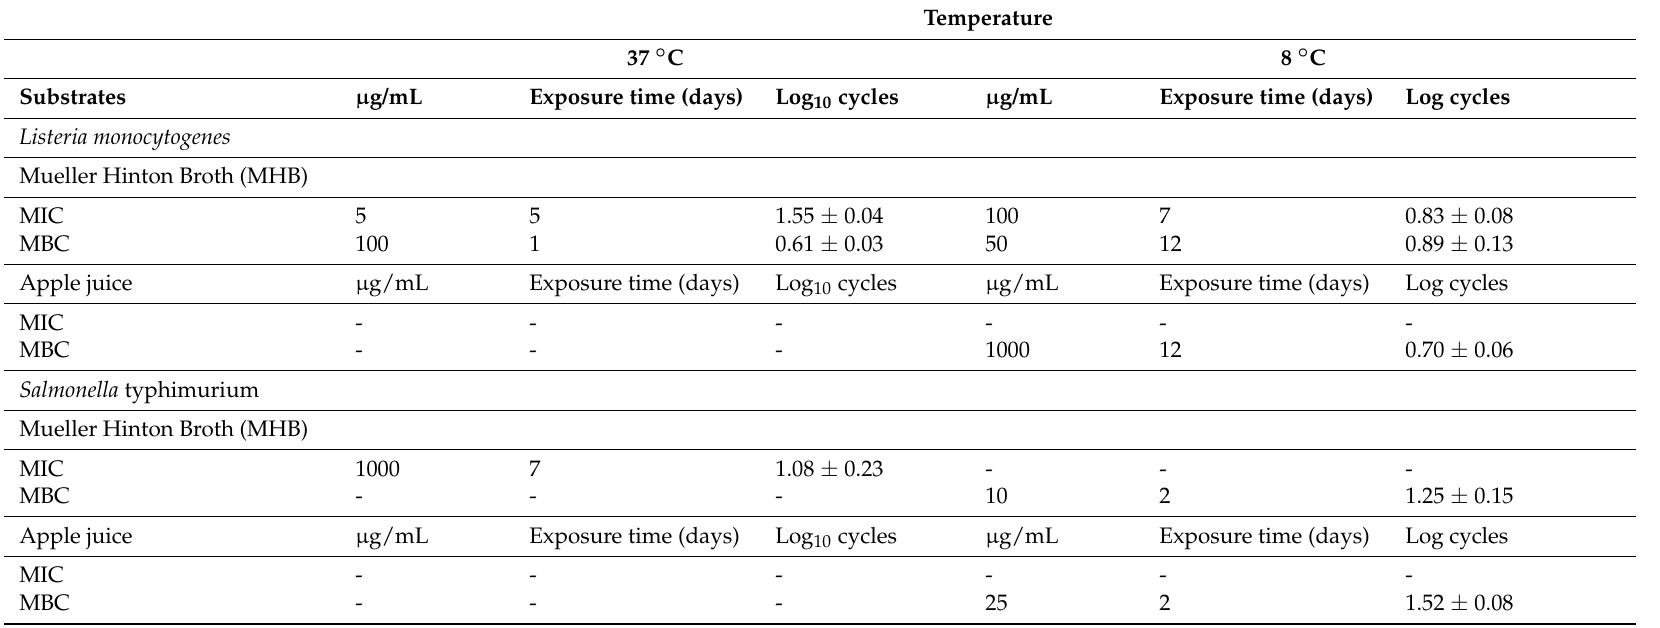
Table 1. Fucoidan bacteriostatic and bactericidal potential against Listeria monocytogenes and Salmonella typhimurium in reference medium and in an apple juice-based